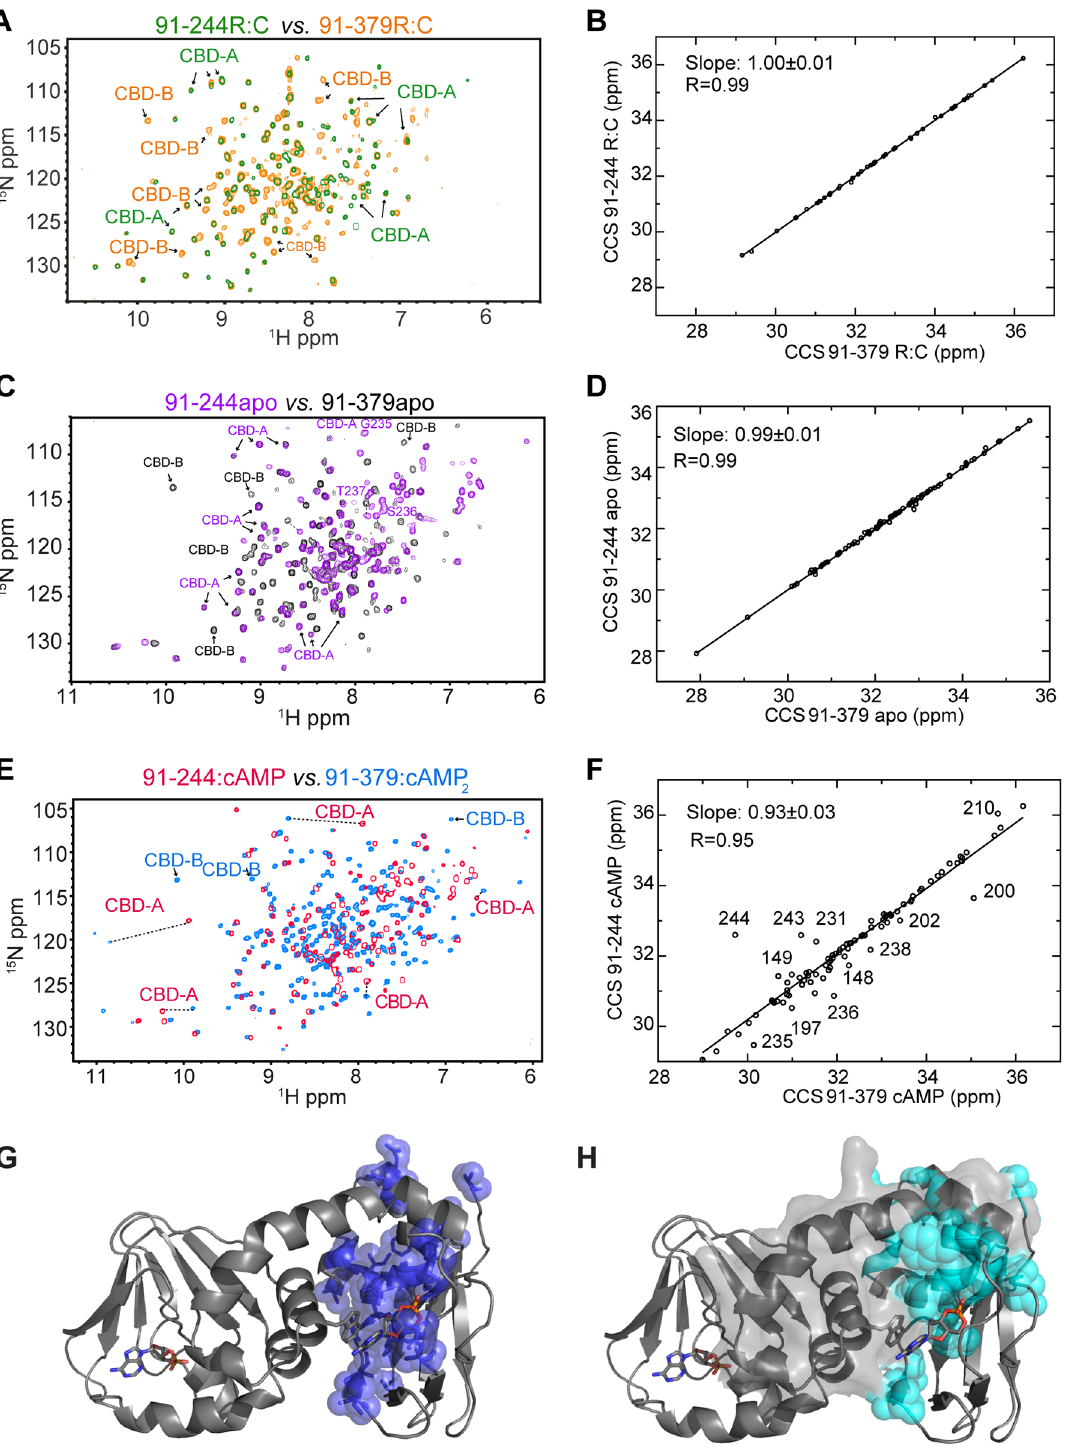
Fig 3. Probing CBD-A/B interactions in apo, C-bound, and cAMP 2 -bound RI α (91 – 379) through CBD-B deletion. (A) Overlay of the HN-TROSY spectra of C-bound RI α (91 – 379) and RI α (91 – 244), in which CBD-B is deleted. (B) Correlation between the combined chemical shifts (CCS) of C-bound RI α (91 – 379) and RI α (91 – 244). (C, D) As in panels (A, B), but for the apo forms of RI α (91 – 379) and RI α (91 – 244). (E, F) As in panels (A, B), but for the cAMP 2 - bound form of RI α (91 – 379) and the cAMP-bound form of RI α (91 – 244). Color codes for panels A, C, and E are indicated in the figure and representative CBD-A and -B cross-peaks are labeled. (G) Map of above-average RI α (91 – 379):cAMP 2 versus RI α (91 – 244):cAMP CCS differences for residues < 226 (blue